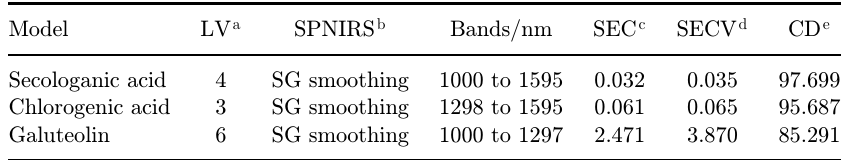
Table 5. Parameters of the ¯nal calibration models.